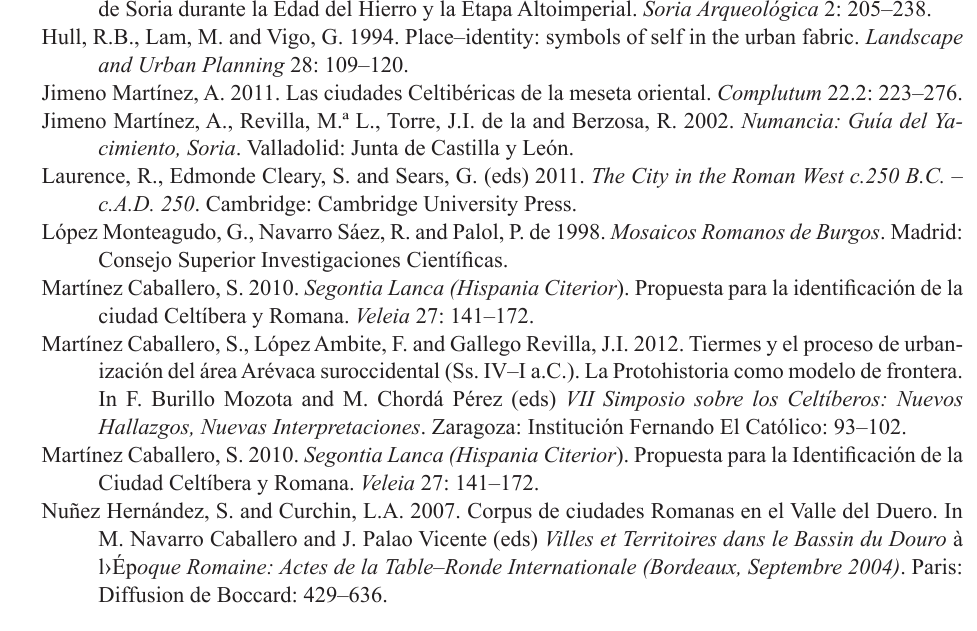
l›Ép oque Romaine: Actes de la Table–Ronde Internationale (Bordeaux, Septembre 2004) . Paris: Diffusion de Boccard: